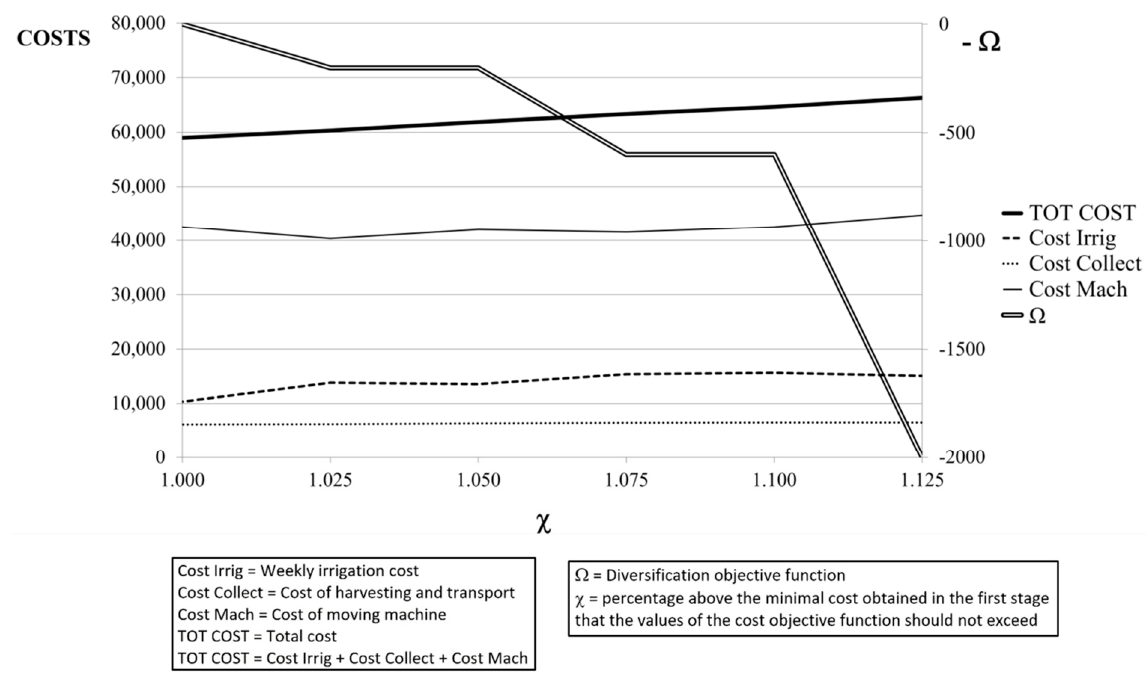
Figure 3. Evolution of the diversification objective function ( Ω ), as costs are allowed to increase (controlled by parameter χ ) above the minimum value.